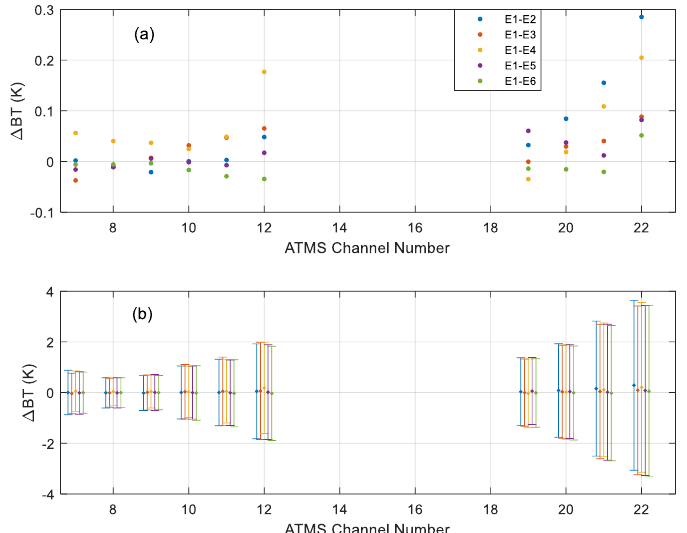
Figure 19. Evaluation of precision of STAR COSMIC-2 wet profile retrievals through deriving BT differences of ATMS channels between COSMIC-2 E1 and five other COSMIC-2 sensors by using ATMS as the reference sensor in the double-difference method: ( a ) Zoom-in of BT differences, and ( b ) the BT differences with error bar.